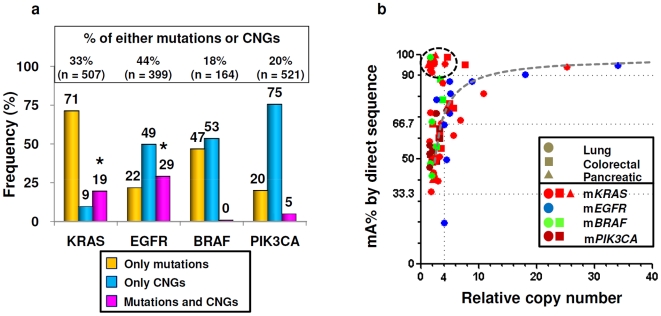
The association between mutations, copy number gain (CNG) and mutant allele specific imbalance (MASI) of EGFR pathway genes.a) The association between mutations and CNG of EGFR pathway genes in cell lines and tumors across organs. We combined the data of cell lines and tumors because of similarity of both data sets. Mutations are more frequent than CNG in KRAS gene while CNG are more frequent than mutations in other genes. CNG are significantly correlated with mutations in KRAS (P<0.0001) and EGFR (P<0.0001) genes (*). However, mutations or CNGs of BRAF and PIK3CA genes are usually exclusive and rarely present together. b) The association between percent of mutant allele (mA%) and copy number for 75 mutations in 68 mutant cell lines. Gray dotted line is the hypothetical curve of mutant allele specific amplification. There were 36 mutations with MASI (48%), 38 with balanced (51%) and one with reverse MASI (1%). Thirteen mutant cell lines including mutant KRAS (n = 12) and BRAF (n = 1) had uniparental disomy (complete MASI without CNG) and four lines (all mutant KRAS) had complete MASI with modest level of CNG (copy number<9, black dotted circle). The prefix m- means mutant; mA%, proportion of mutant allele.